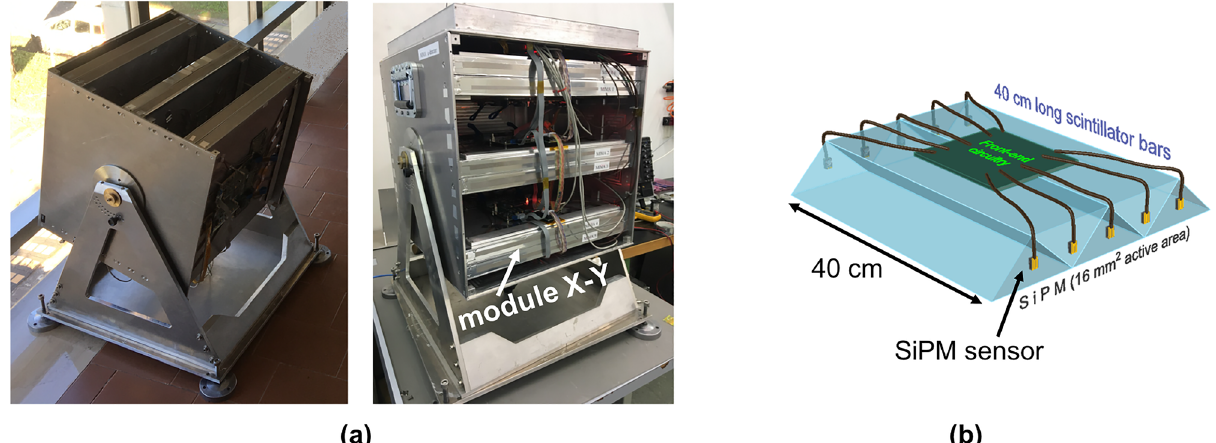
Figure 2. The MIMA muon tracker employed for the muon radiography measurements in the Temperino mine. In ( a ) the detector with the structure of 3 X − Y module of tracking planes. In ( b ) the structure of a single plane consisting of triangular scintillator bars (for simplicity only five bars) is shown 1 .